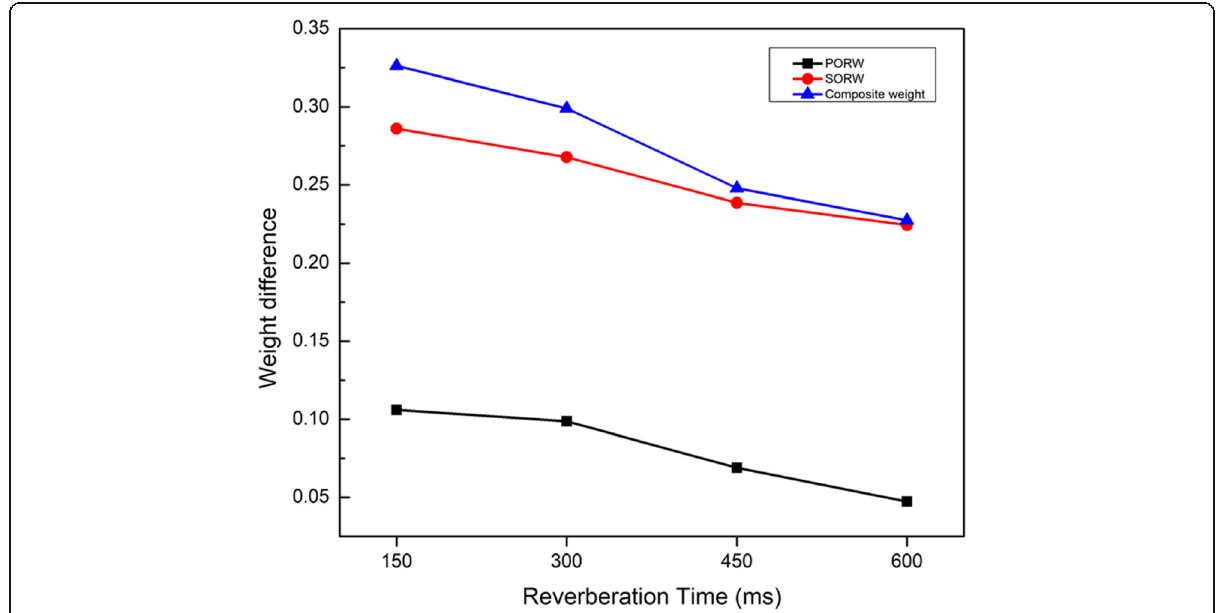
Fig. 7 The difference between weight given to the outliers and desired points